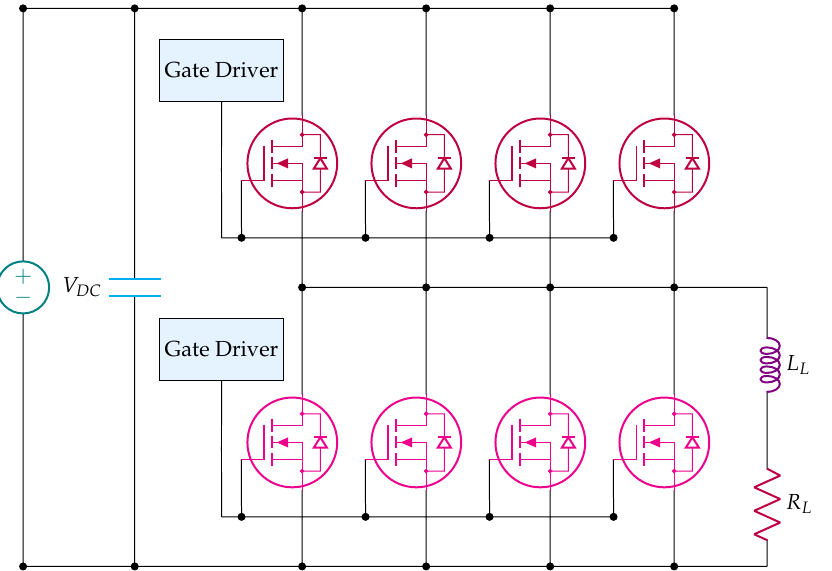
Figure 1. Proposed half-bridge topology with four paralleled SiC MOSFETs.